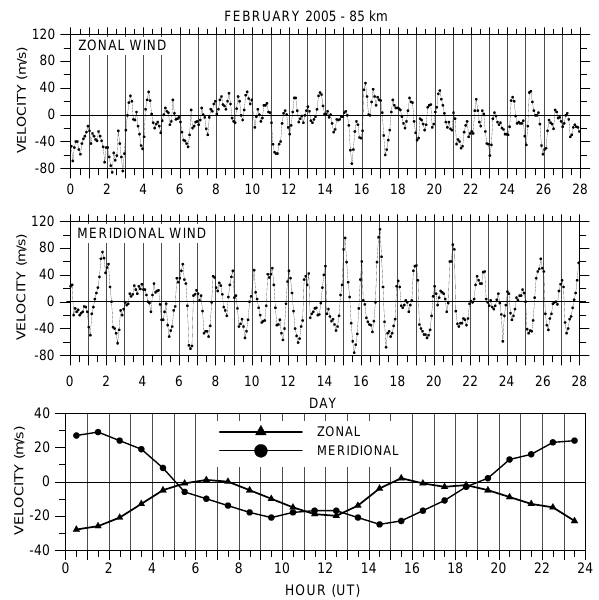
Fig. 3. The two upper plots show the 85-km zonal and meridional winds each 2h from 1 to 28 February. Bottom plot shows the zonal (solid triangles) and meridional (solid circles) hourly winds for a composite day from 00:50 to 23:50 UT at same altitude.